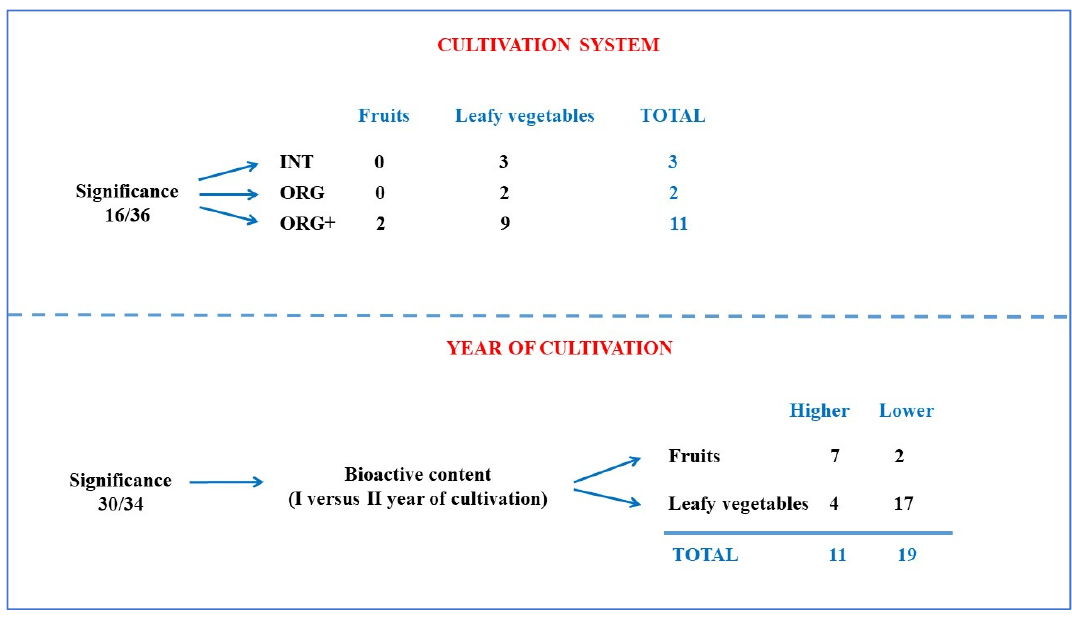
Figure 8. The effects of cultivation system (upper side) and production year (lower side) in fruit crops (tomato, eggplant, and apple) and leafy vegetables (spring and summer lettuce, savoury cabbage, and fennel) cultivated according to three different cropping system: integrated (INT), organic farming (ORG), and organic no-tillage (ORG+) in a two year-rotation experiment. Data indicate the number of observations related to bioactive compounds (chlorophyll, carotenoid, total phenol, and ascorbic acid content) and total antioxidant activity for which the cultivation system allows to obtain the products with the highest bioactive compound levels (upper side).